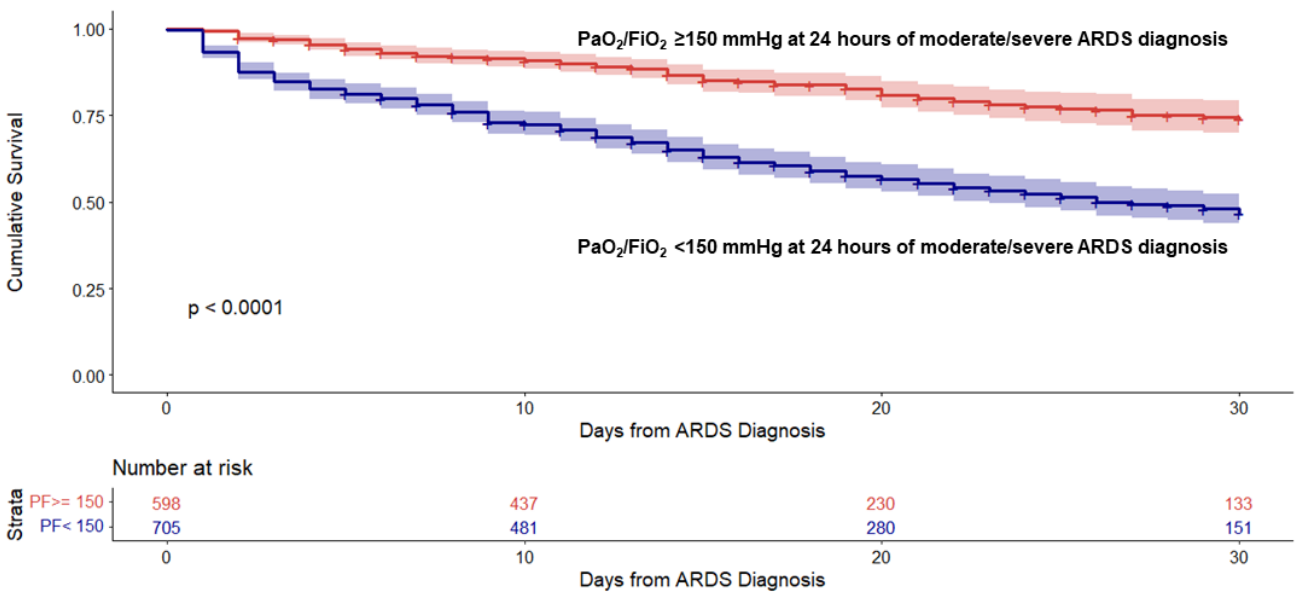
Figure 2. Probability of cumulative ICU survival to Day 30 in 1303 patients with moderate to severe acute respiratory distress syndrome (ARDS). Patients were stratified into two large categories based on cutoff values of 150 mmHg for PaO 2 /FiO 2 (<150 and ≥1 50) at 24 h of study